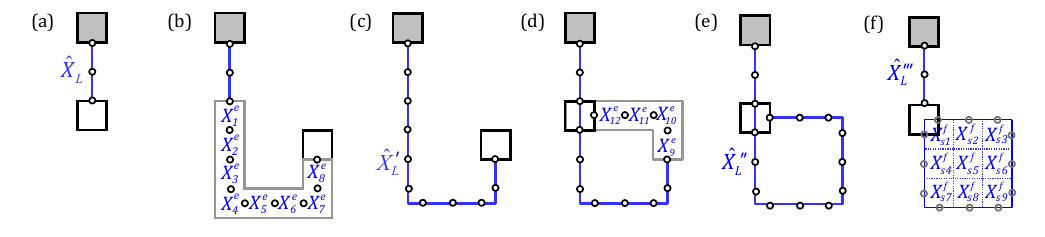
, L = X X ... X . L 1 8 L